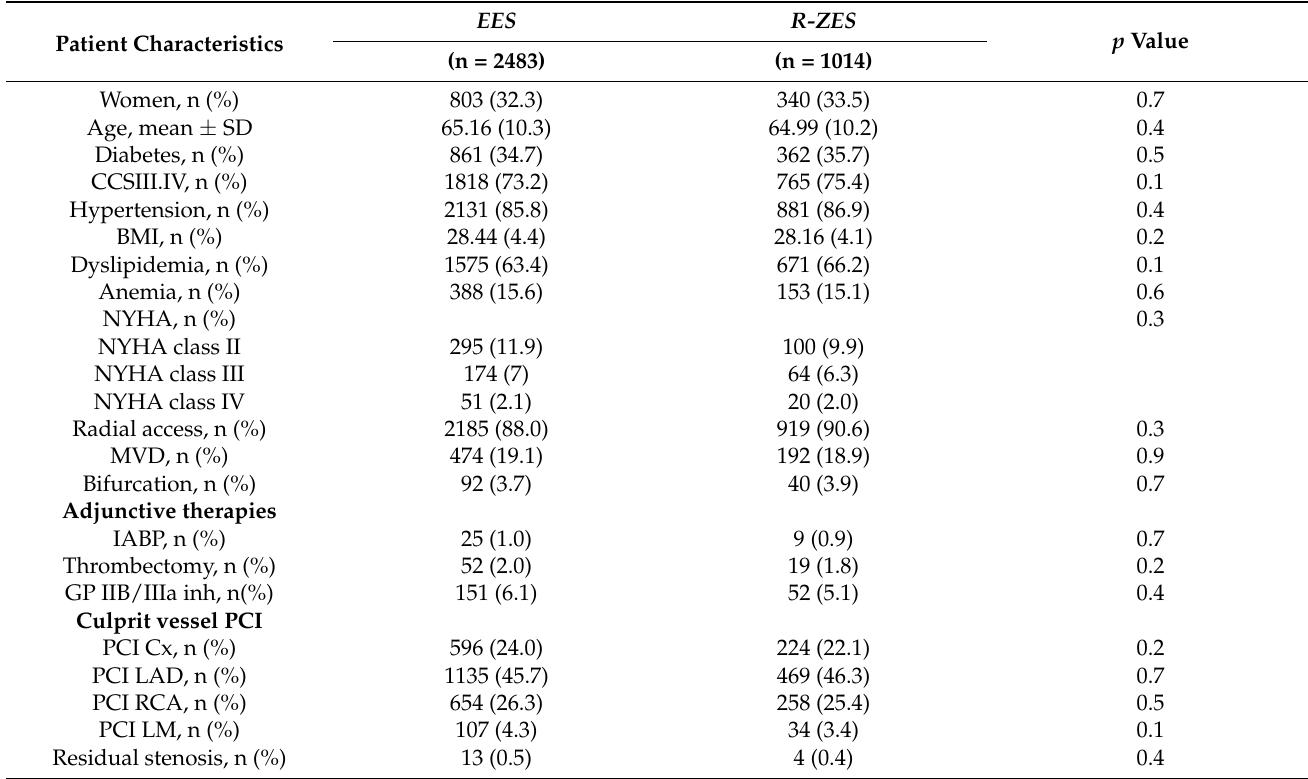
Table 1. The baseline characteristics after propensity matching of ACS patients treated with EES vs. R-ZES. Patient